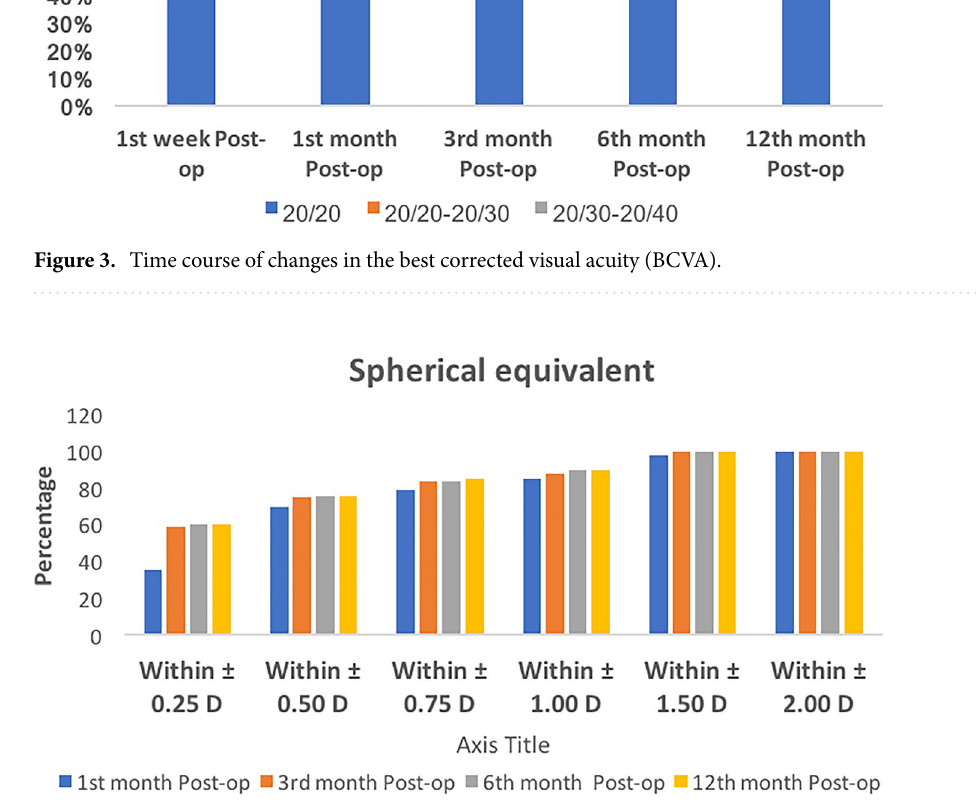
Figure 4. Cumulative bar graph of predictability for spherical equivalent at various post-operative